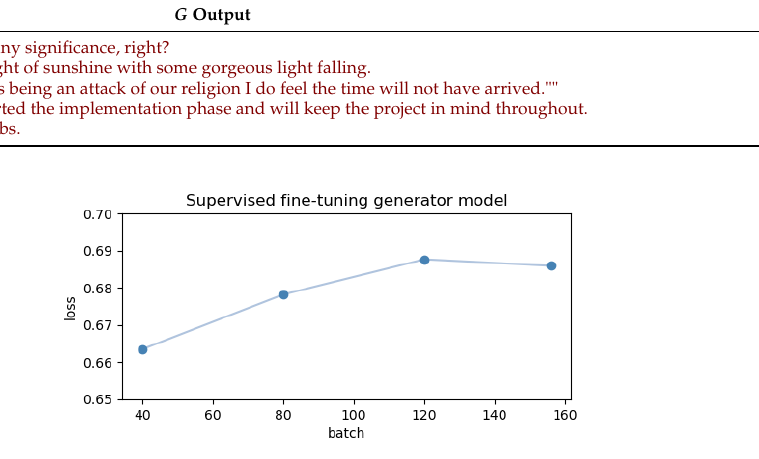
Figure 5. Supervised fine-tuning of the training loss of the GPT-2 medium